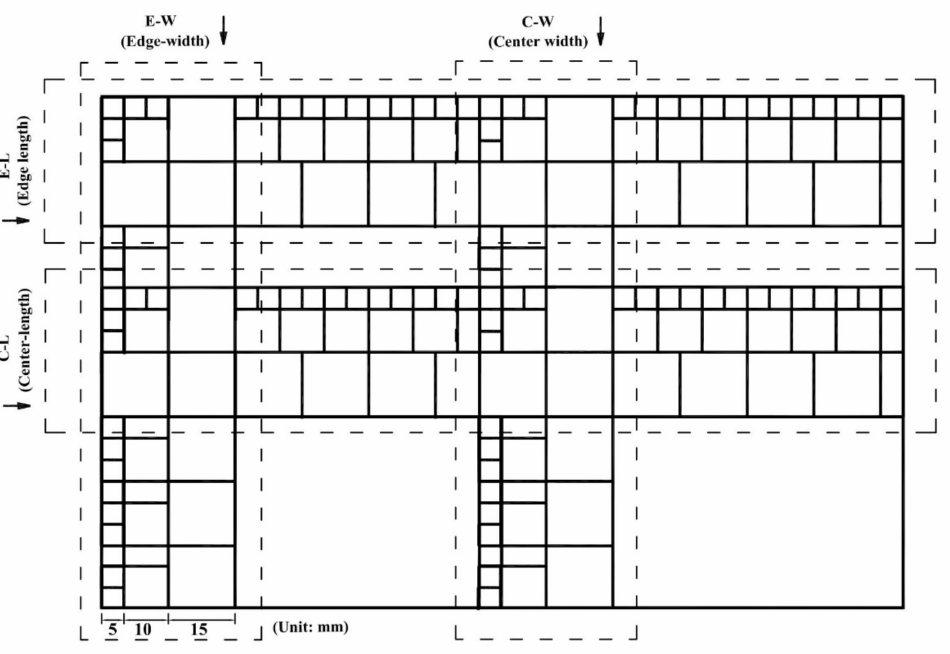
Figure 4. Distribution of density specimens cut from each panel.